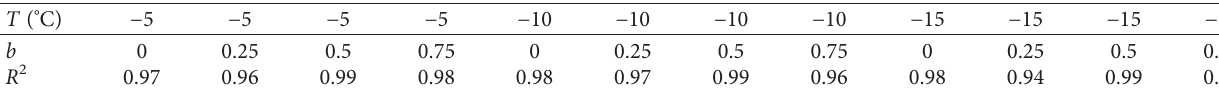
R 2 in this table represents the correlation coefficient.